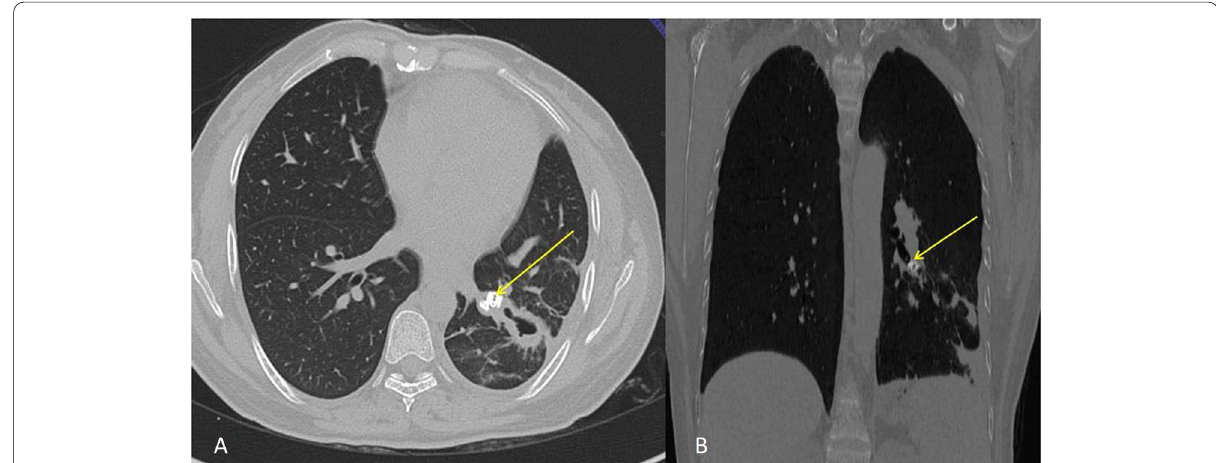
Fig. 5 A Non-contrast axial chest CT and B MinIP in the coronal plane showing vascular plug within the segmental bronchus for the lower lobe with a near total resolution of the cavity. Resolution of the previously noted subcutaneous